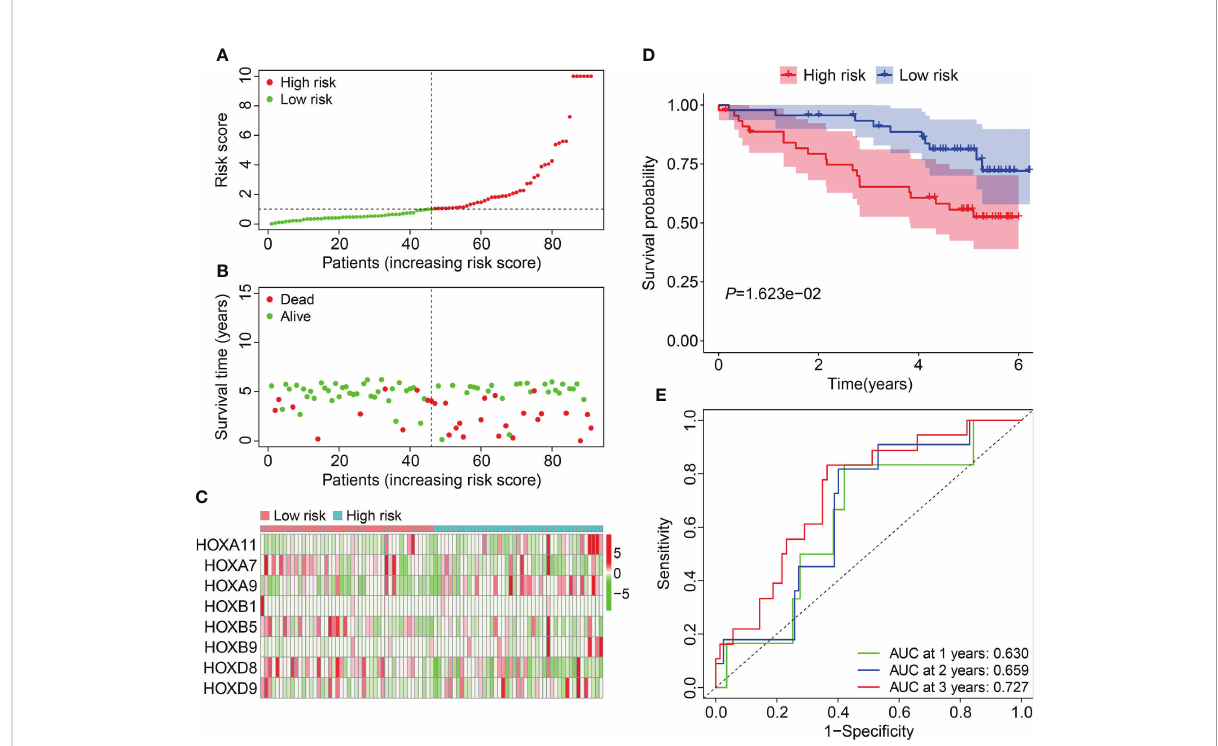
FIGURE 5 Validation of the HOX family gene-based signature in external ICGC cohort. (A) The pro fi le of risk score in ICGC cohort. (B) The distribution of survival time and living status in ICGC cohort. (C) The expression patterns of the three HOX family genes in ICGC cohort. (D) Kaplan-Meier